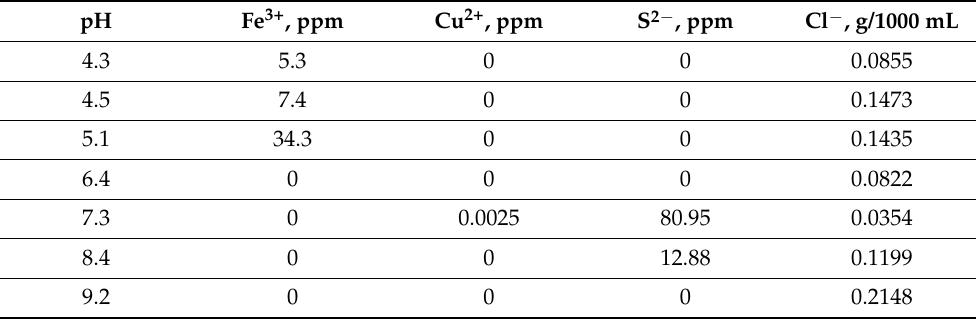
Table 3. Results obtained from the analysis of the product samples taken from the reflux vessel of the distillation column.